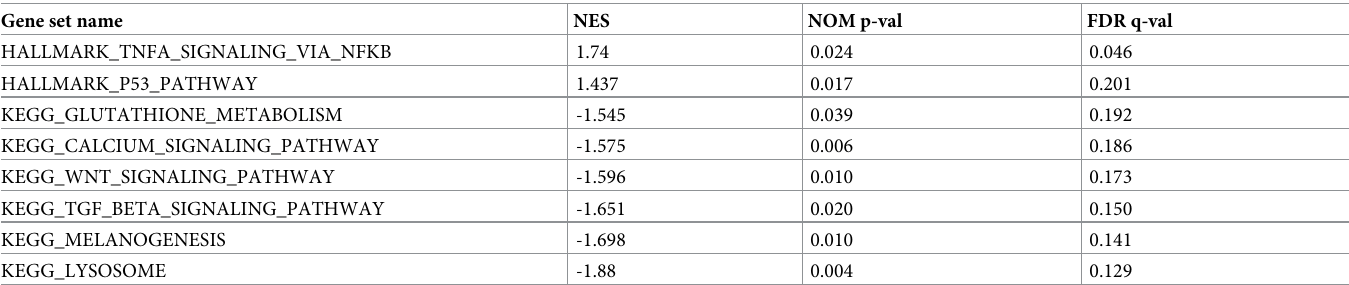
Table 3. Gene set enrichment